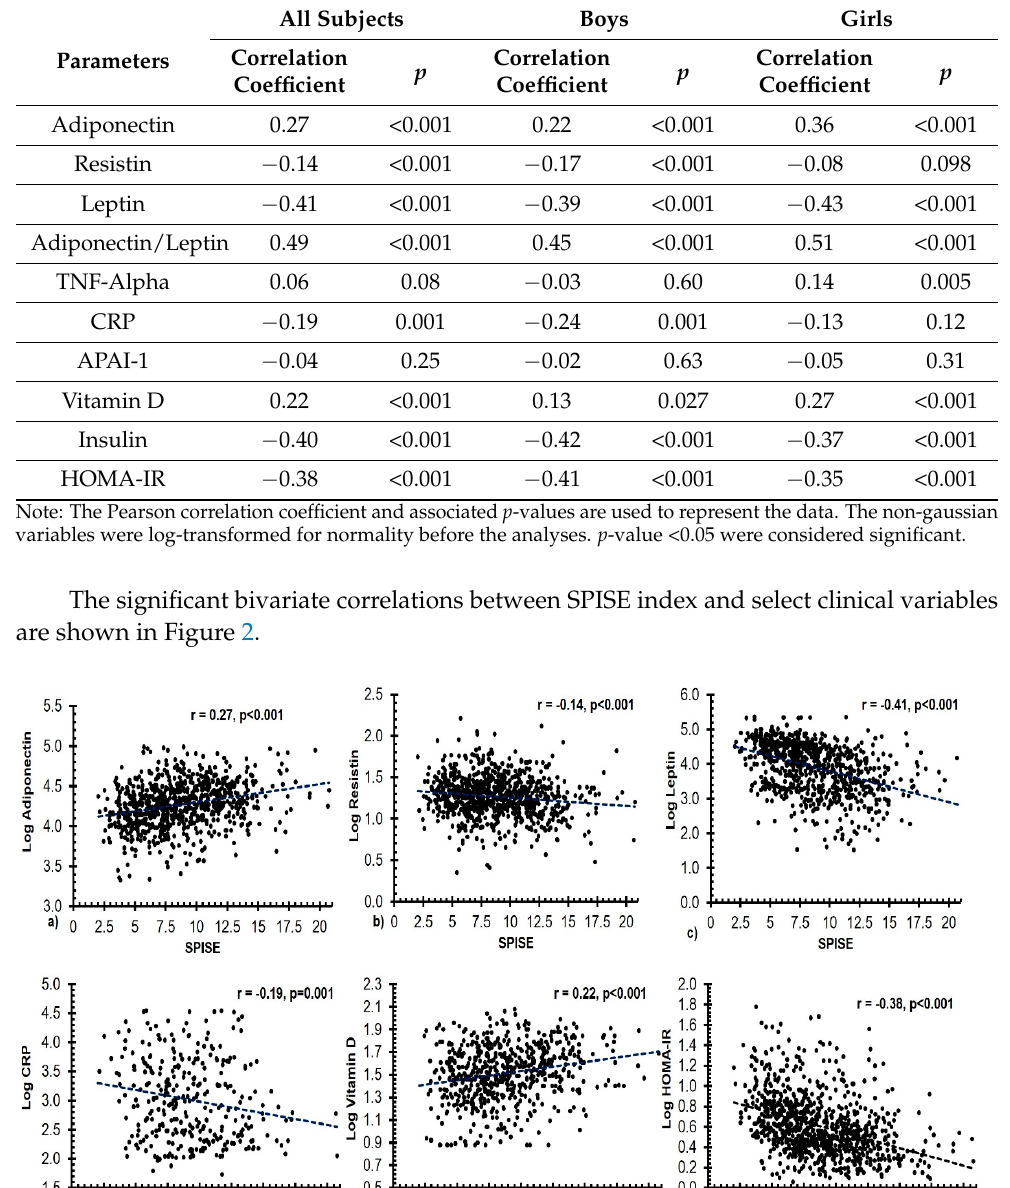
Table 3. Bivariate correlation analyses between SPISE index and measured clinical parameters.